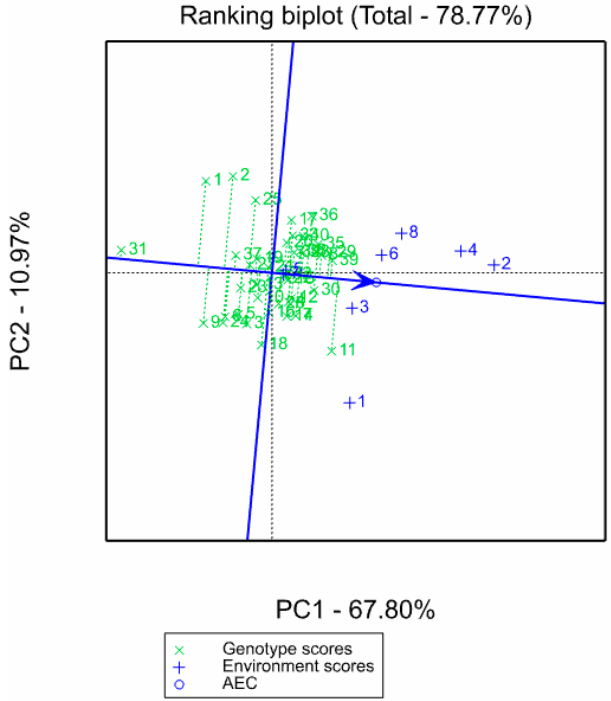
Figure 1. Biplot of the average environment coordination (AEC) view showing the mean performance and stability of diallel cross genotypes (1–36) and checks (37–40) across eight low-nitrogen and optimal sites in Zimbabwe and Zambia.